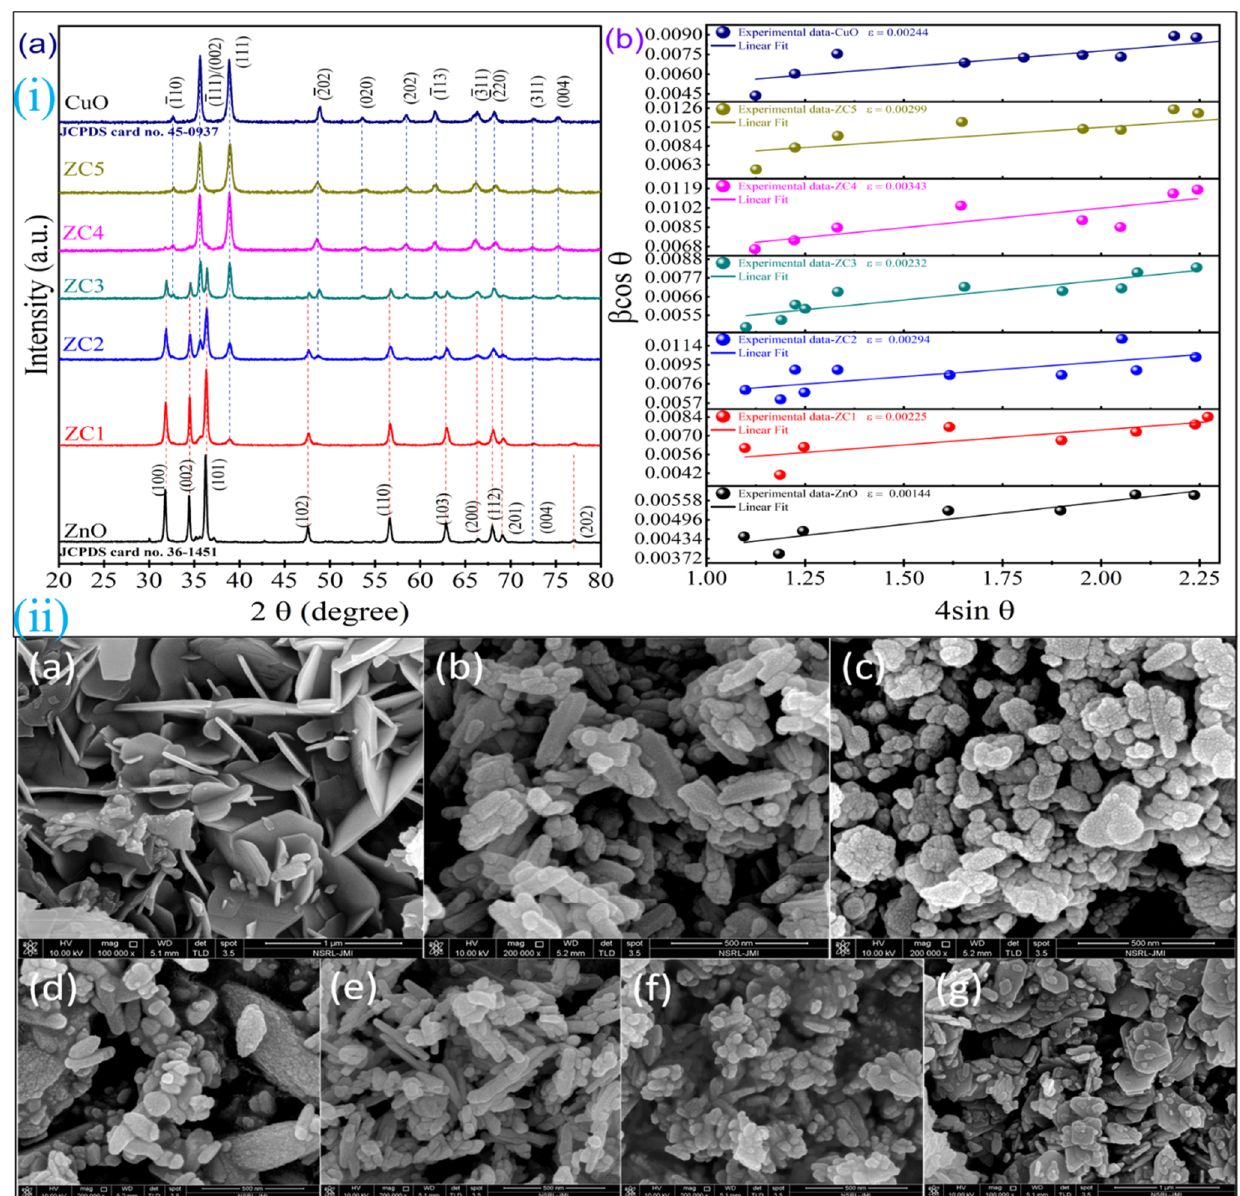
Figure 1. ( i ) ( a ) XRD and ( b ) W-H plot of ZnO, CuO, and ZnO/CuO; ( ii ) FESEM micrograph of ( a ) ZnO, ( b ) ZC1, ( c ) ZC2, ( d ) ZC3, ( e ) ZC4, ( f ) ZC5, and ( g ) CuO nanoparticles.